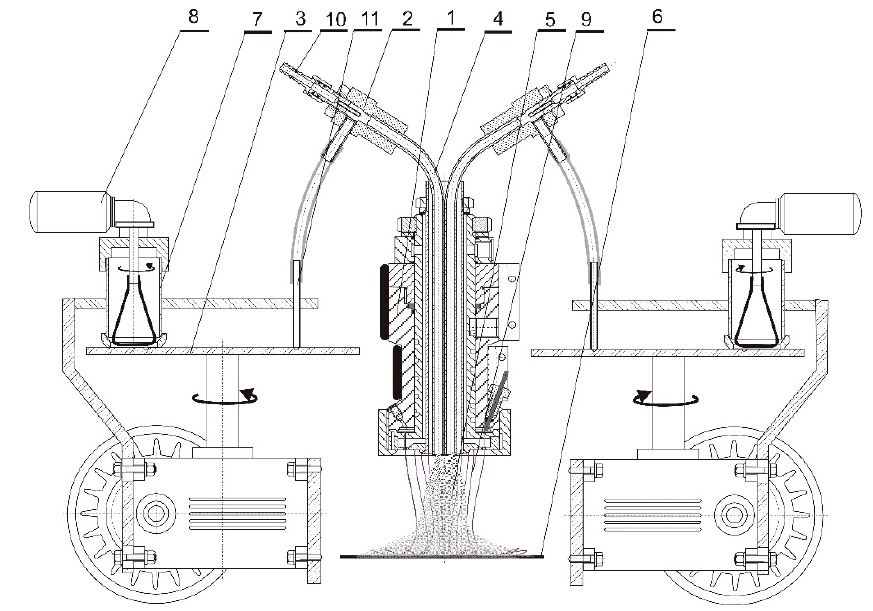
Figure 2. The process of applying two modifiers to the stream of elementary fibers in melt-blown technology. 1—fiber-forming head, 2—injector, 3—modifier dispenser plate, 4—tube transporting the modifiers to the fiber-forming zone, 5—mixed modifiers, 6—nonwoven layer, 7—modifier tank,